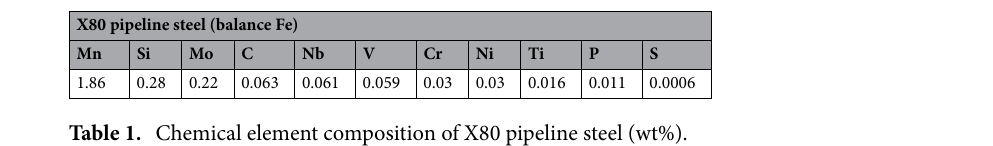
Table 1. Chemical element composition of X80 pipeline steel (wt%).